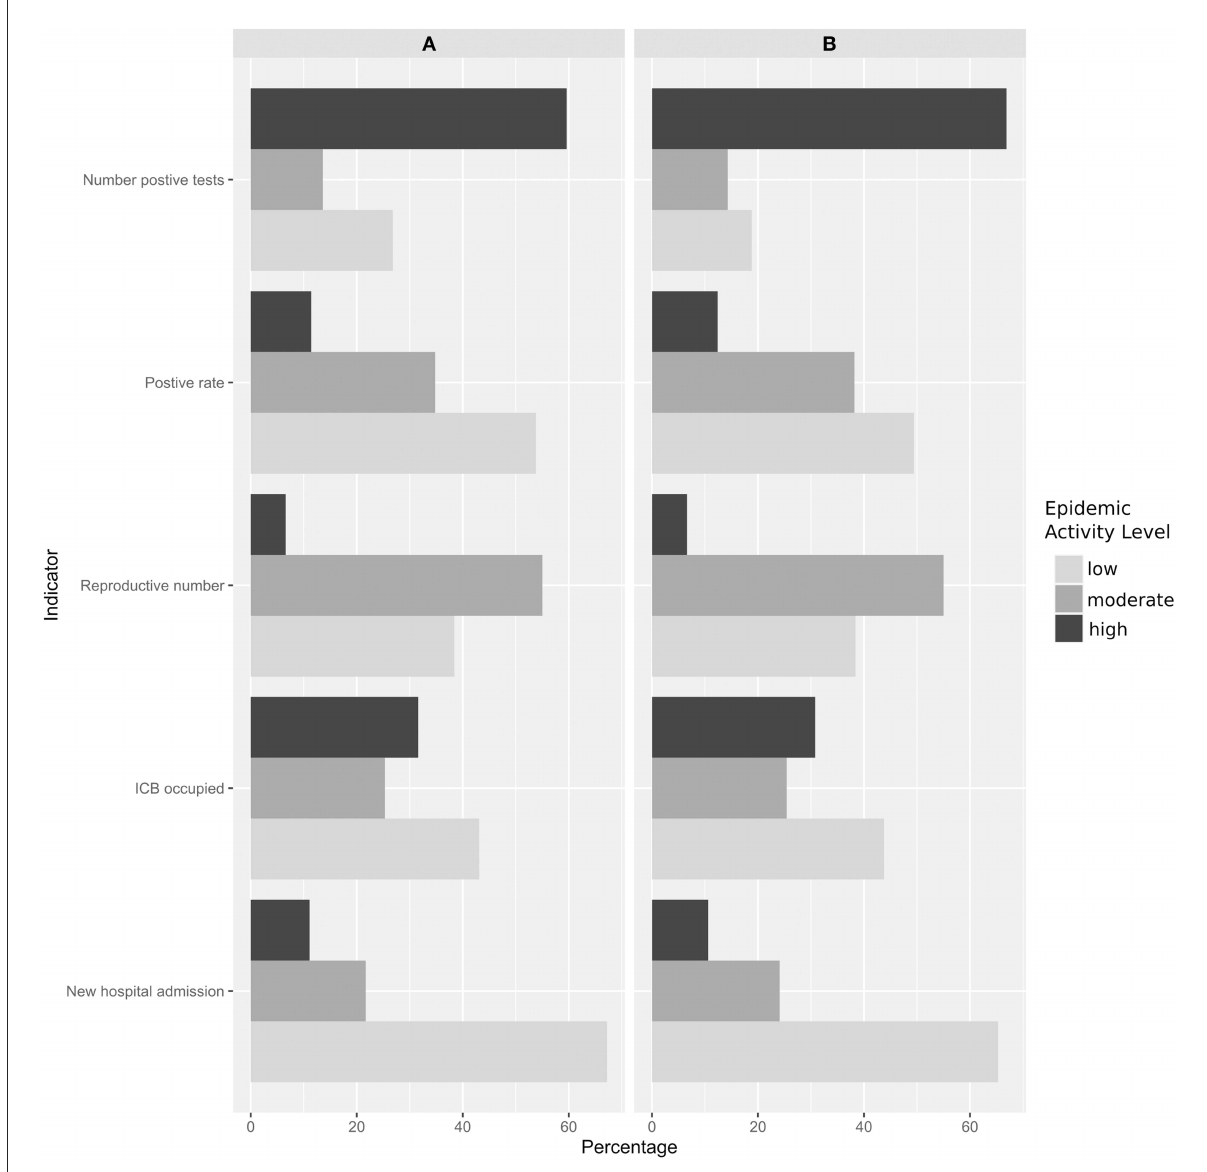
FIGURE1 Percentage of weeks, for all counties, categorized as high, moderate, and low epidemic activity by the indicators considering (A) all the study period and (B) the date when all indicators were available (18 June